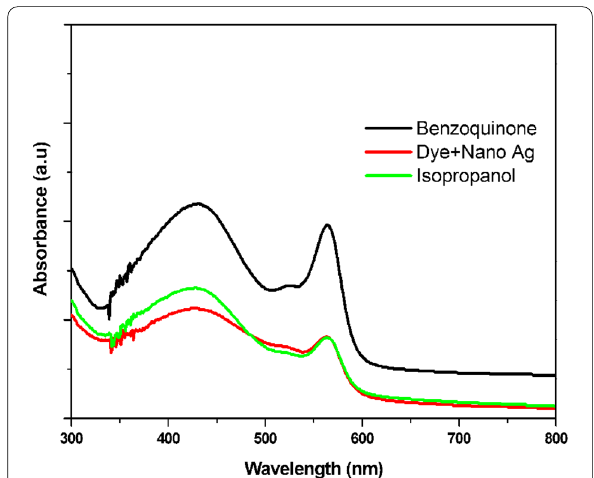
Fig. 12 Optical absorbance for the mixture of dye with Ag nano-particle kept in dark along with Isopropanol as a quencher for *OH and 1,4-benzoquinone as a quencher for *O 2 species